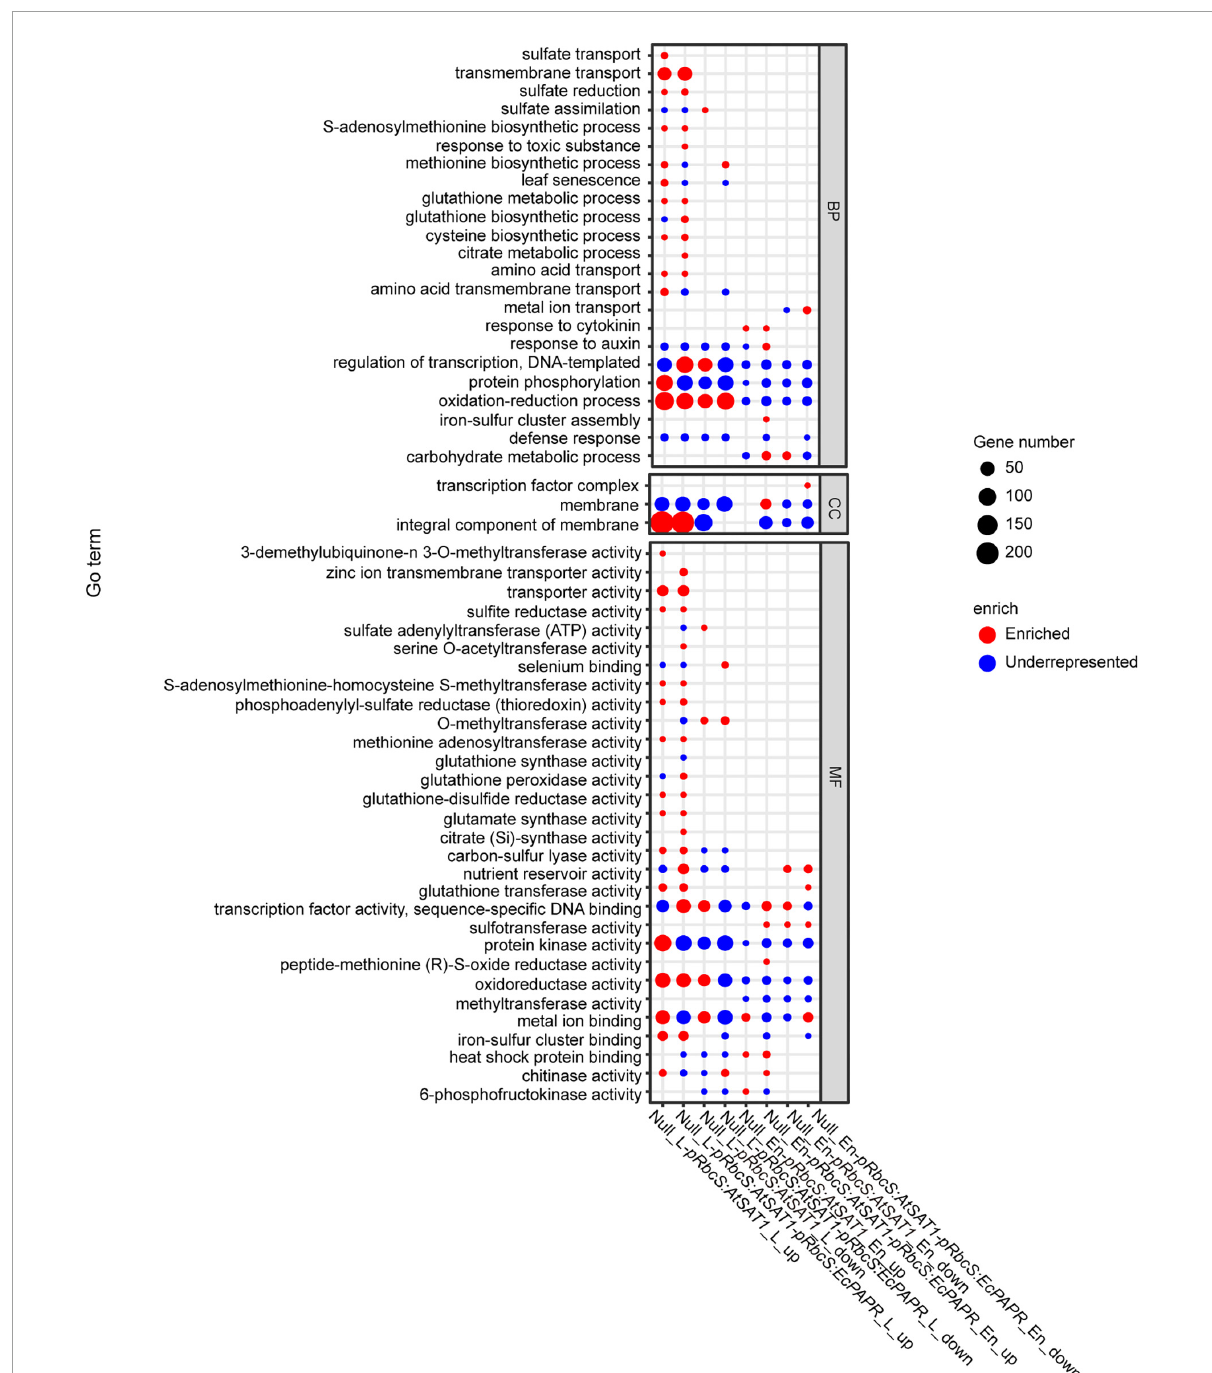
FIGURE4 GO enrichment of DEGs across the comparisons. The Y-axis shows the GO term (correct p -value < 0.05). The x -axis indicates the enriched factor. The point sizes describe the enriched numbers in each term. The red color indicates enriched. The blue color indicates those that are underrepresented. (The figure was created by gg plot of the R language.)